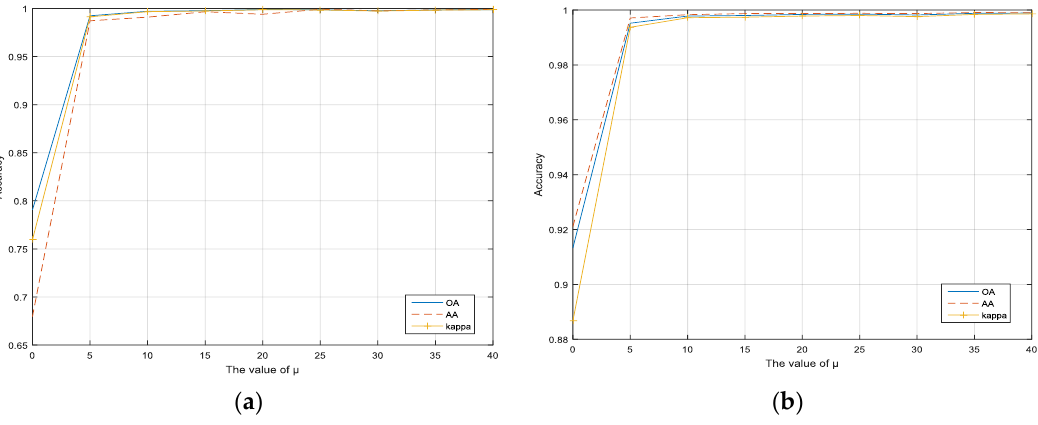
Figure 4. The impact of sparseness parameters μ in the datasets: ( a ) Indian Pines; ( b ) Pavia University.